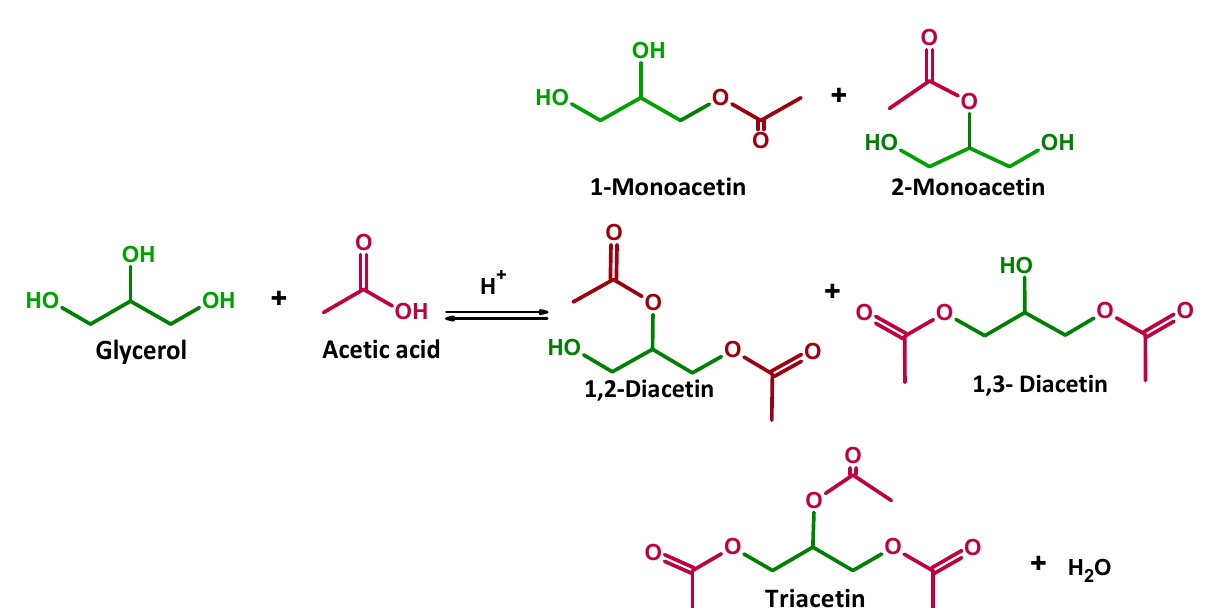
Figure 1. Schematic illustration of the EG reaction in the presence of acetic acid.